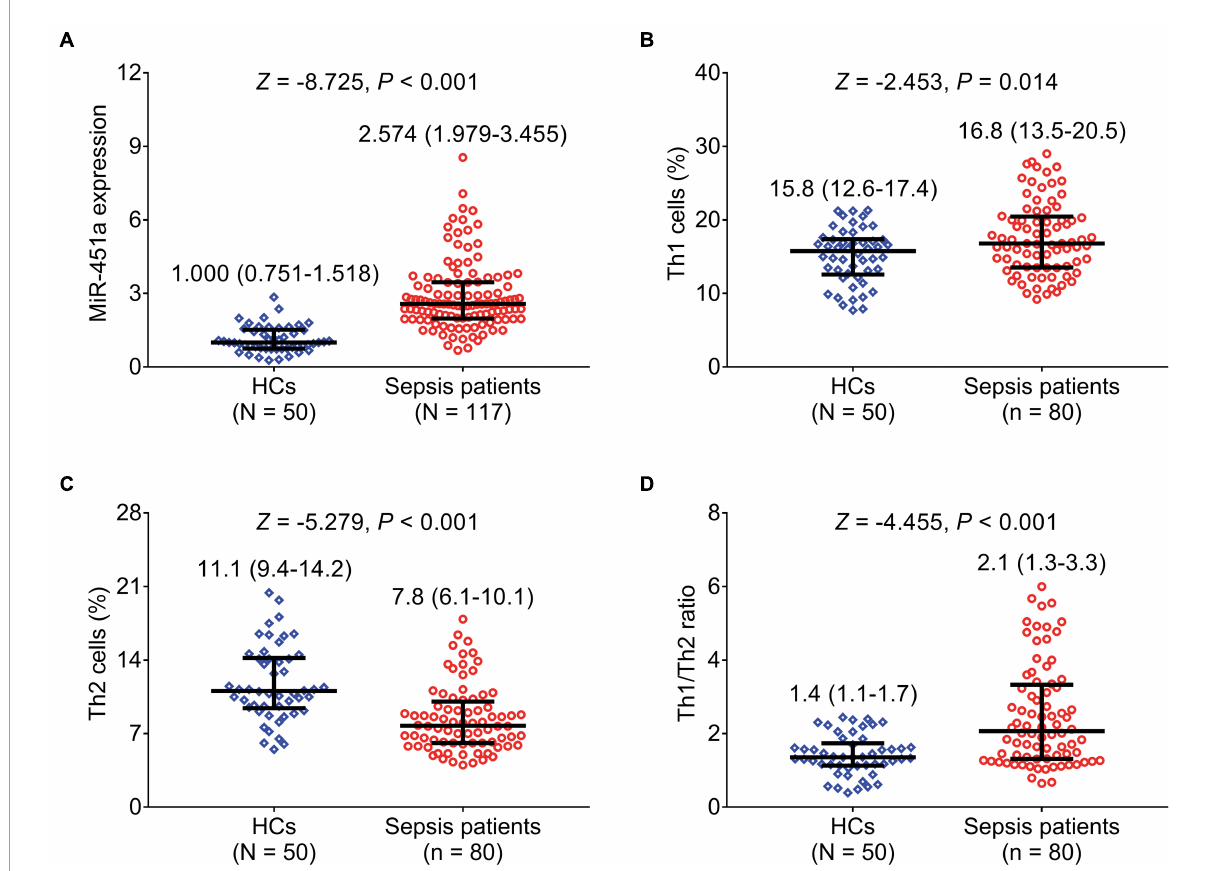
FIGURE1 MiR-451a, Th1 cells, and Th2 cells were dysregulated in patients with sepsis. Comparison of miR-451a (A) , Th1 cells (B) , Th2 cells (C) , and the Th1/Th2 ratio (D) between patients with sepsis and HCs.